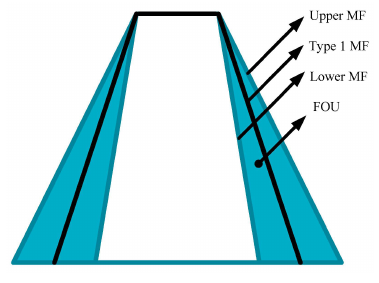
Figure 1. Interval Type-2 Membership